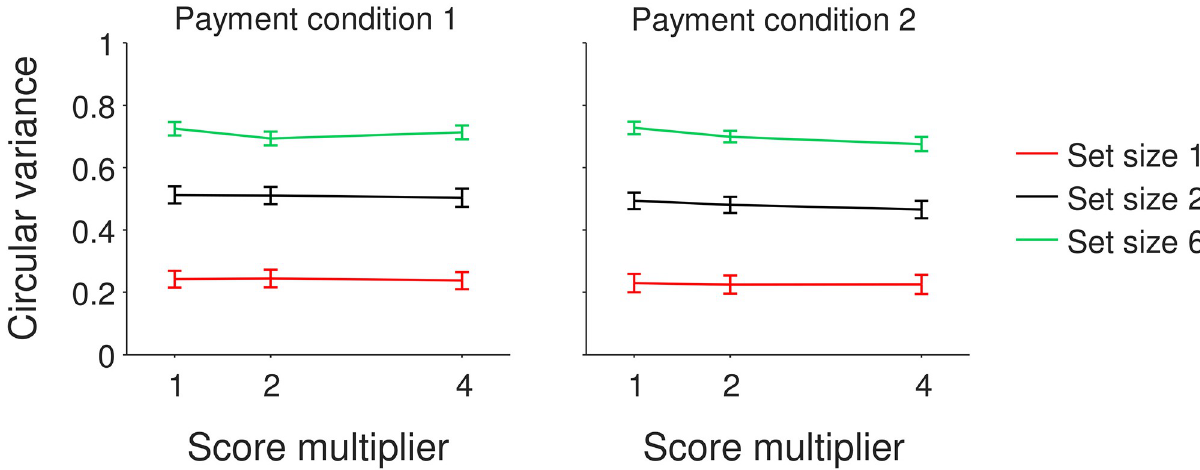
Fig 4. Effect of monetary reward level on memory precision in Experiment 3. (A) Subject-averaged circular variance of the estimation error distribution as a function of the trial-by-trial score multiplier. Payment Condition 1 refers to the group of subjects whose bonus was calculated on the score summed across all trials and Payment Condition 2 to the group whose bonus was calculated on 9 randomly selected trials. Error bars indicate 1 s. e.m.